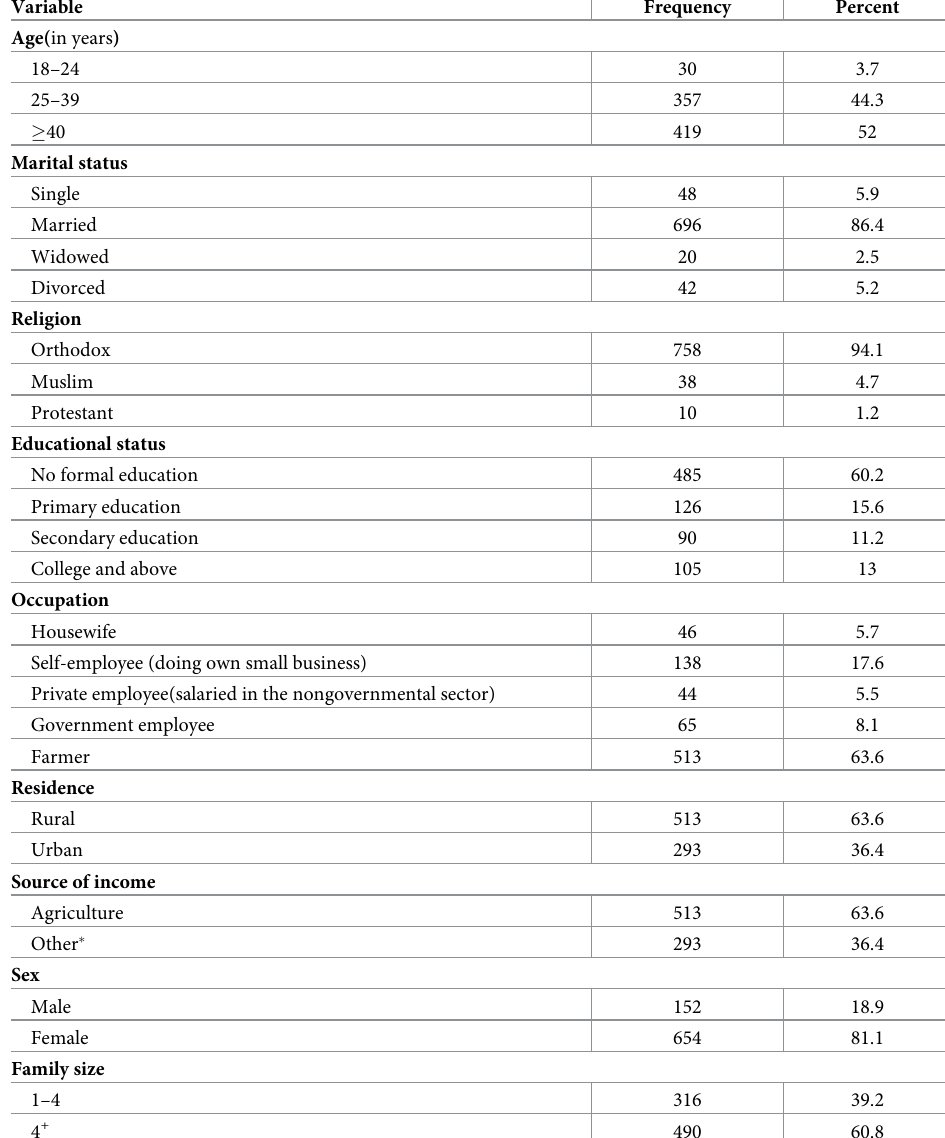
Table 1. Sociodemographic characteristics of respondents (n = 806) in East Gojjam Zone, Northwest Ethiopia,